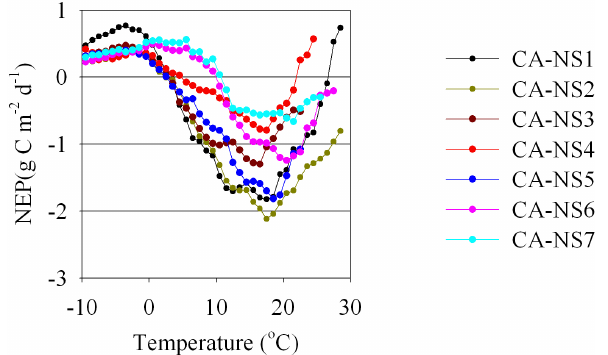
Fig. 4. Temperature response curves of NEE at seven adjacent ev- ergreen needleleaf forests in Canada shown at Table 1. Negative values at y-axes indicate that carbon is absorbed by the ecosystem, while positive values indicate that carbon is released by the ecosys- tem to the